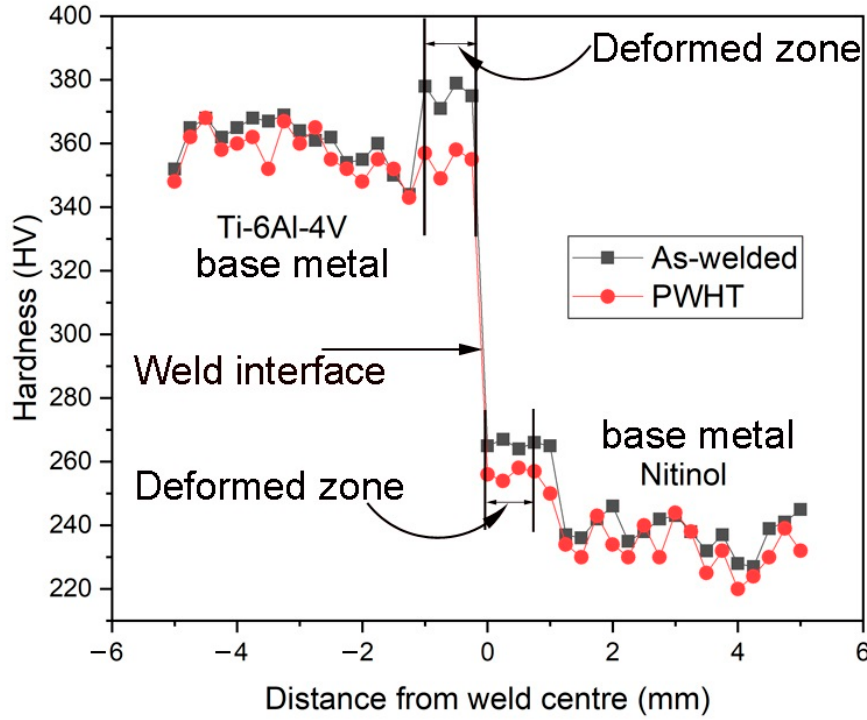
Figure 10. Hardness distribution across the interface of dissimilar Ti-6Al-4V/Nitinol linear friction welds in the as-welded and PWHT